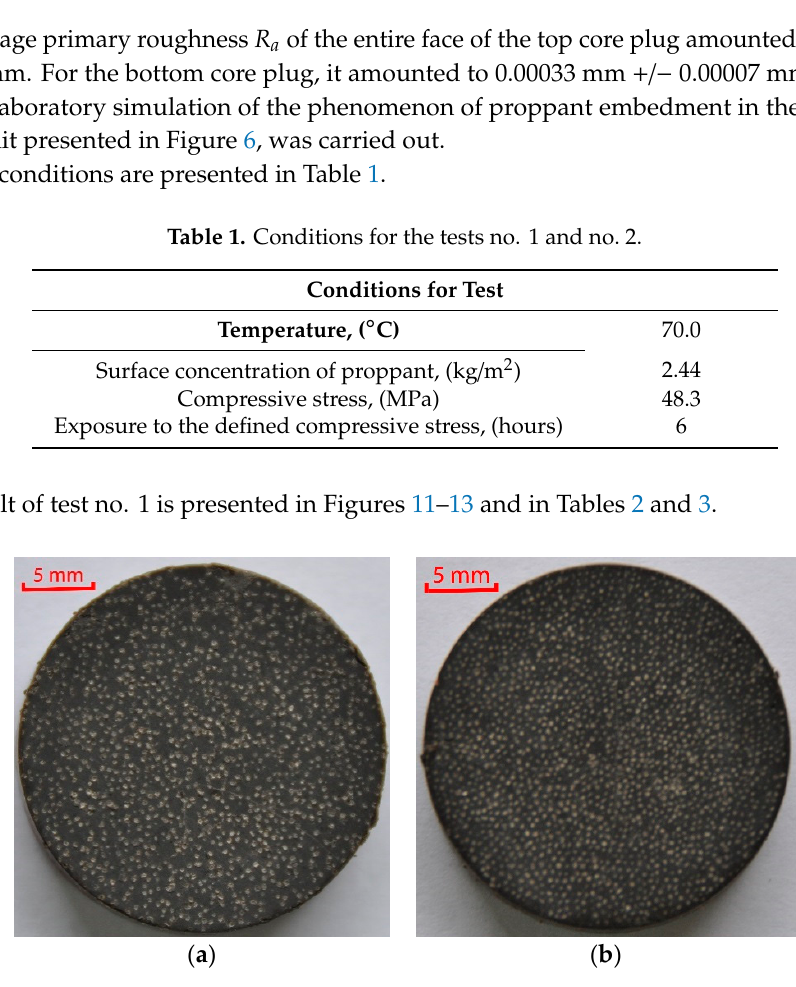
Figure 10. Determination of the primary roughness of the core plug face (fracture faces): ( a ) Top; ( b ) Bottom.